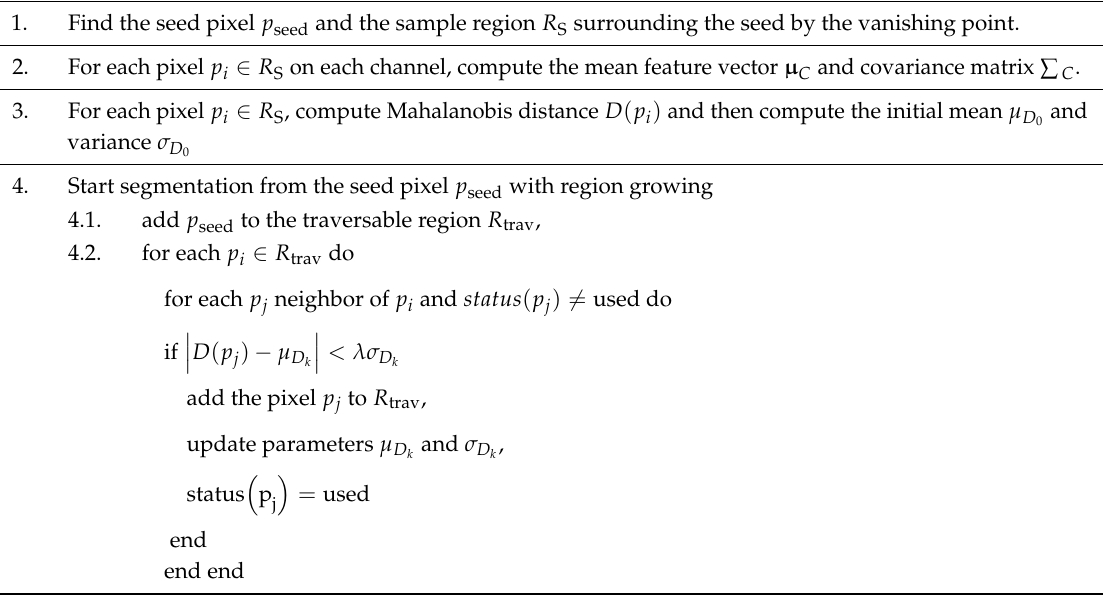
Algorithm 2. Traversable Region